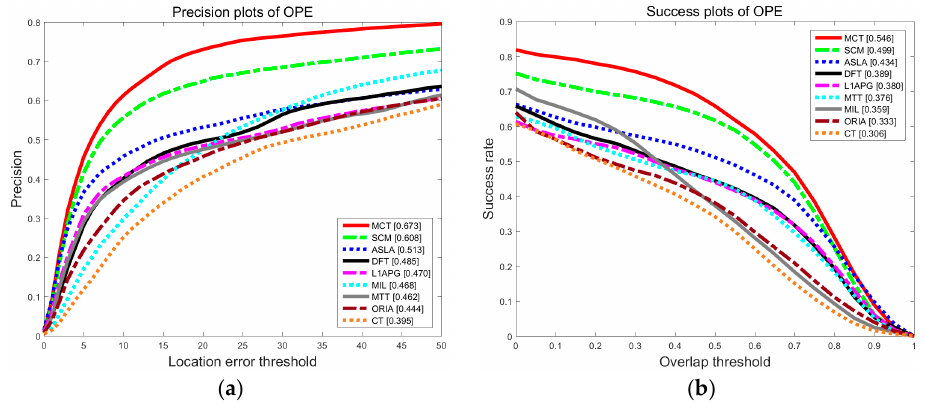
Figure 5. The precision plot ( a ) and the success rate plot ( b ) of the tracking results on OTB for overall performances.